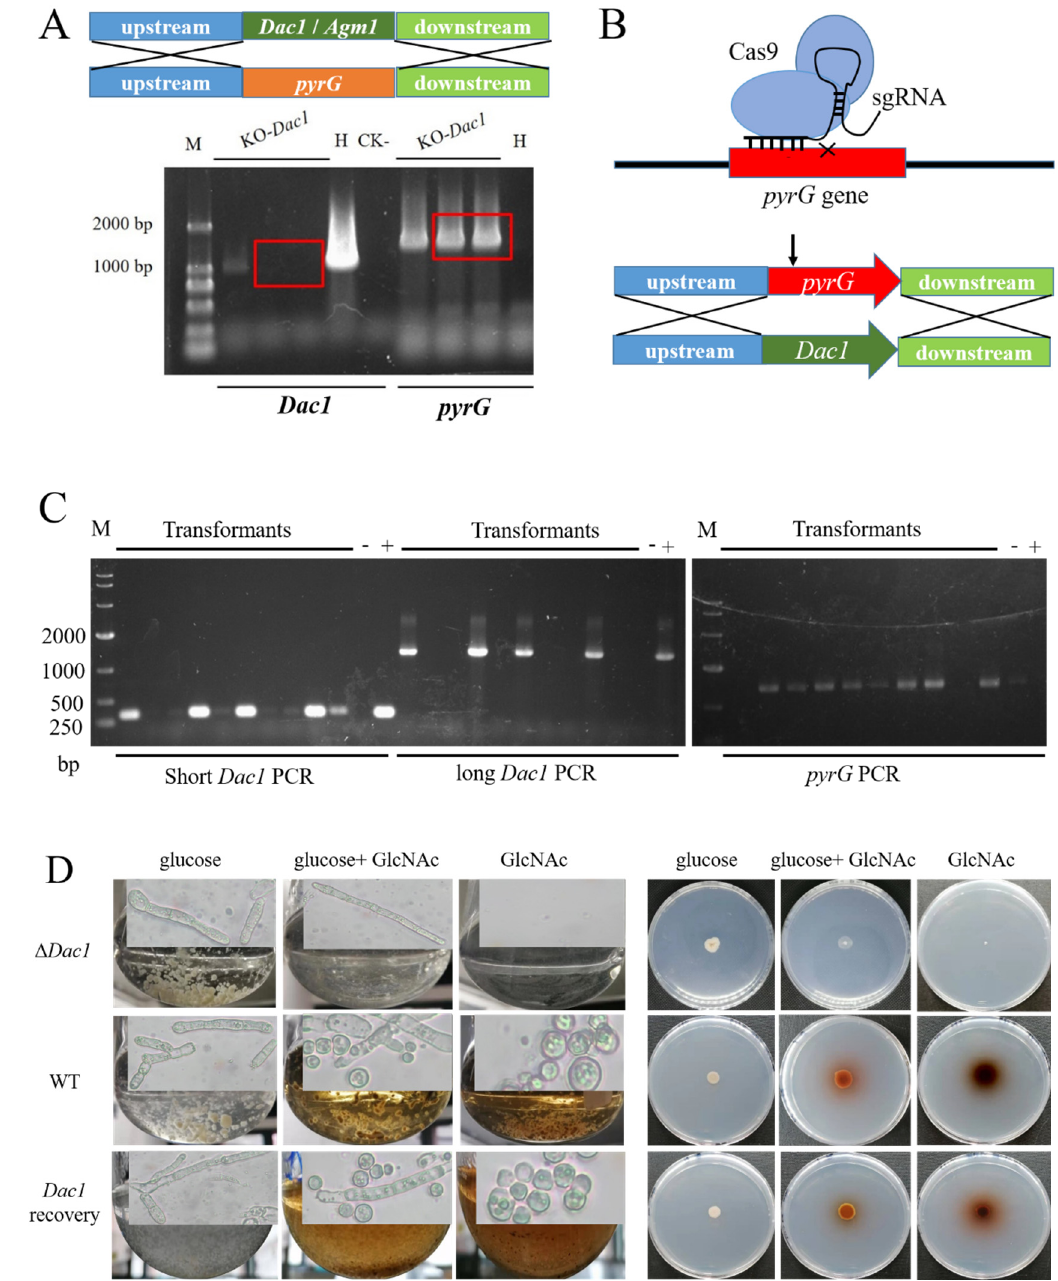
Figure 5. The phenotypes assay of Dac1 gene knockout and in-situ complementation mutants in Aspergillus niger SH2. ( A ) The flowchart of gene knockout and the identification of the gene knockout mutants by PCR. ( B ) One step method was used to recycle the screening tag ( pyrG ) and recover the Dac1 gene by the CRISPR-Cas9 system. ( C ) The PCR identification of Dac1 recovery strains. ( D ) The phenotypes and micromorphology assay of Dac1 gene knockout, in-situ complementation mutants, and wild strain in CD, NGCD and NCD mediums.